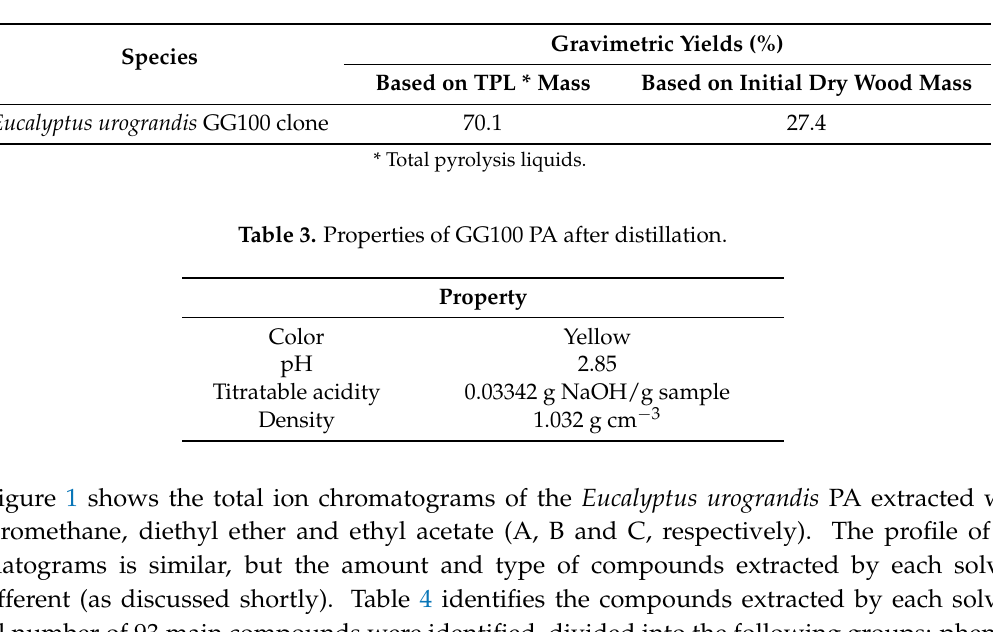
Table 2. Gravimetric yields of purified PA from distillation.